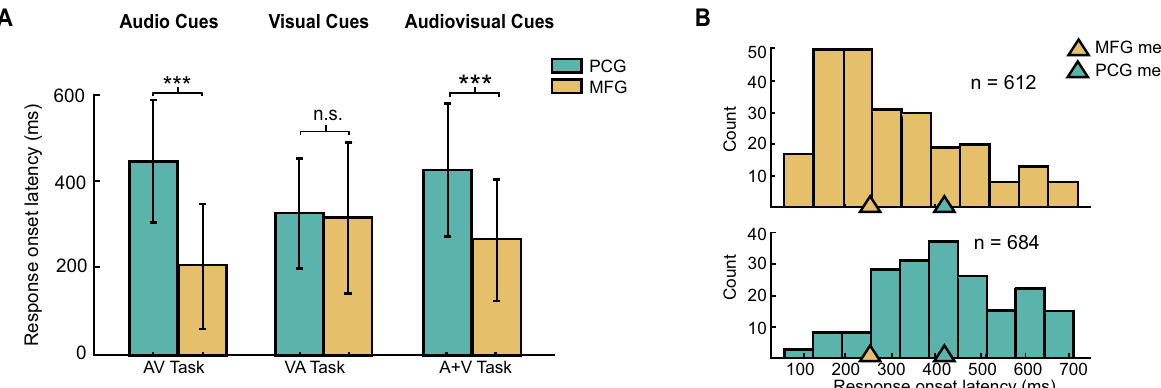
Figure 5. Average MFG neuron response onset precedes that of PCG. ( A ) Median response onset latencies for all PCG ( teal ) and MFG ( yellow ) single neurons following cue onset in the AV, VA, and A + V trials of the Multi-modal task. PCG bar plots represent an average of n = 20 (AV), 13.6 (VA), and 32.3 (A + V) latency values per session, while the MFG bar plots represent an average of n = 41.6 (AV), 20.6 (VA), 34.3 (A + V) latency values per session. Latencies were pooled across all three data collection sessions for each trial type. A KW test was used to assess statistical significance between each pair of MFG and PCG distributions (***, p < 0.001; n.s., p > = 0.05). ( B ) Histograms of PCG ( teal ) and MFG ( yellow ) single neuron response onset latencies pooled across all three conditions referenced in ( A ), where n = number of neurons. Teal and yellow triangles represent the median response onset latencies PCG and MFG, respectively. This figure was compiled using MATLAB 2019, MathWorks software and labeled using Adobe Illustrator CC